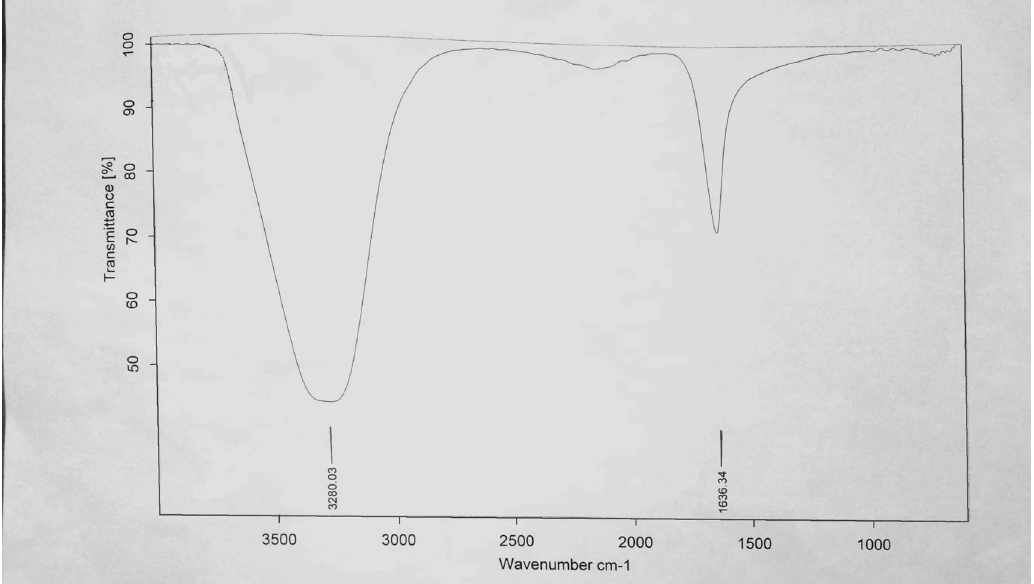
Figure 3. FTIR Spectrum for FeNPs synthesized by Phoenix dactylifera leaves